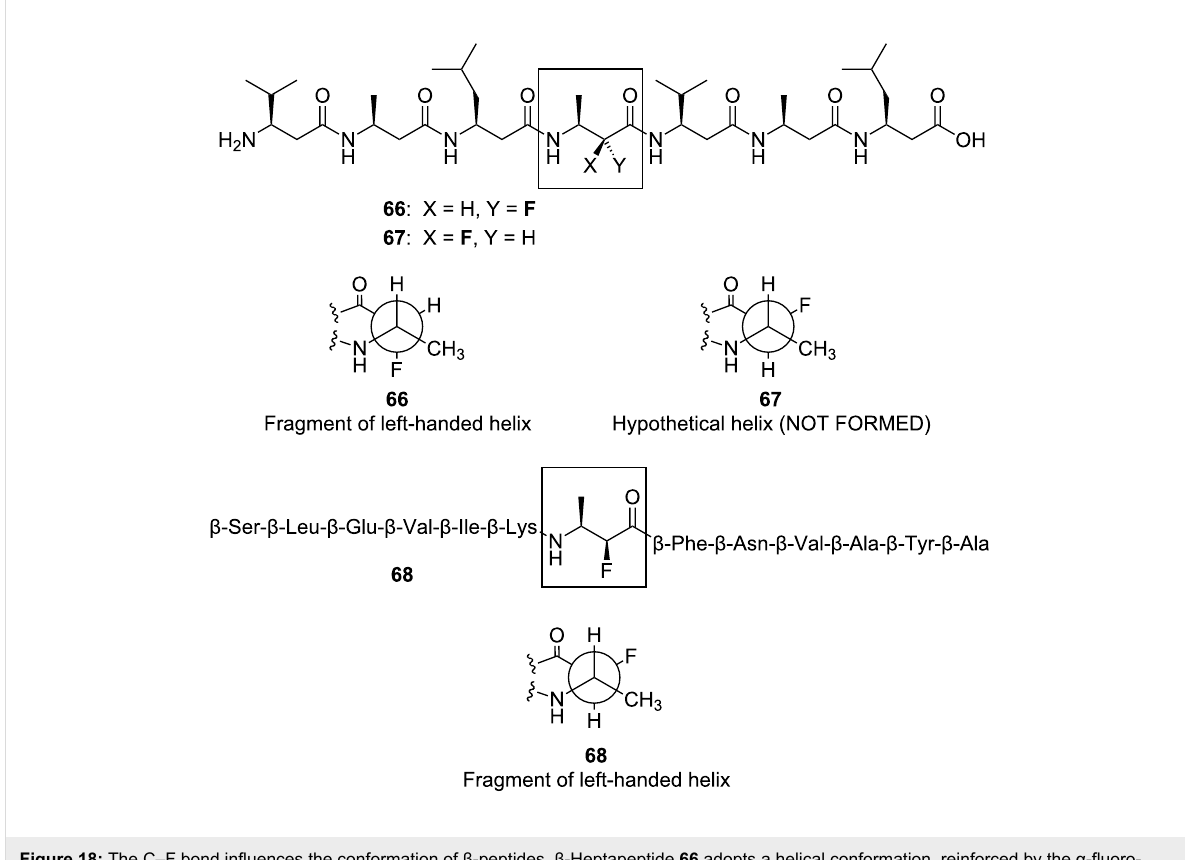
Figure 18: The C–F bond influences the conformation of β -peptides. β -Heptapeptide 66 adopts a helical conformation, reinforced by the α -fluoro- amide effect and a fluorine-amide gauche alignment. In isomeric β -heptapeptide 67 , the helical conformation is disrupted by the fluorine atom. The disruptive effect of fluorine is overridden in the longer helix-forming β -tridecapeptide 68